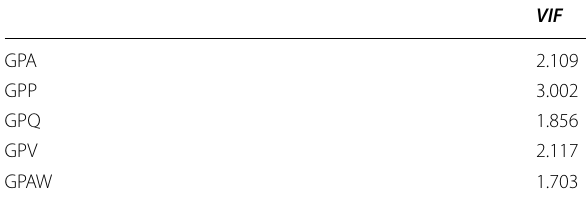
Table 6 Multicollinearity (inner VIF) results